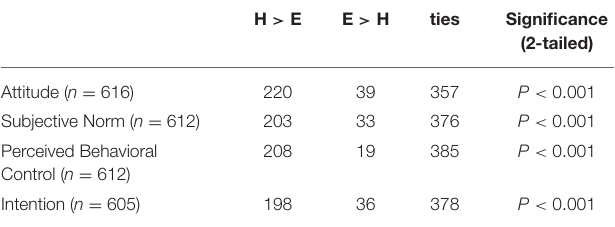
Frontiers in Sustainable Food Systems |